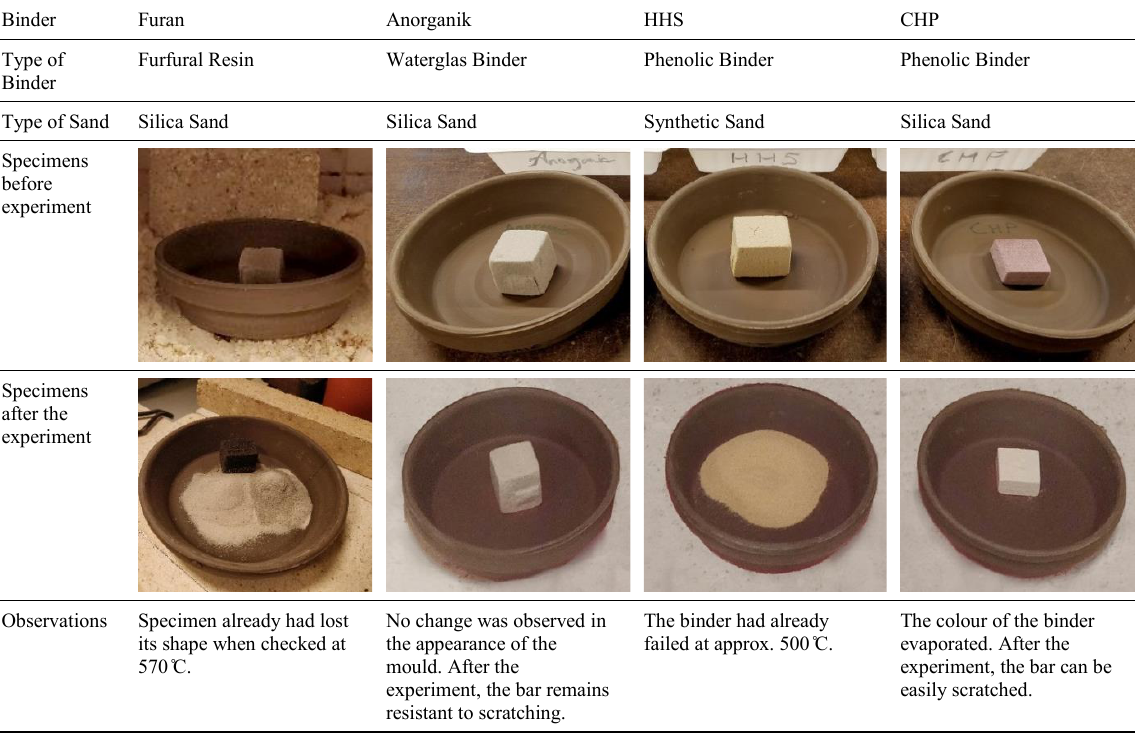
Table 3: Results of 1 st Test